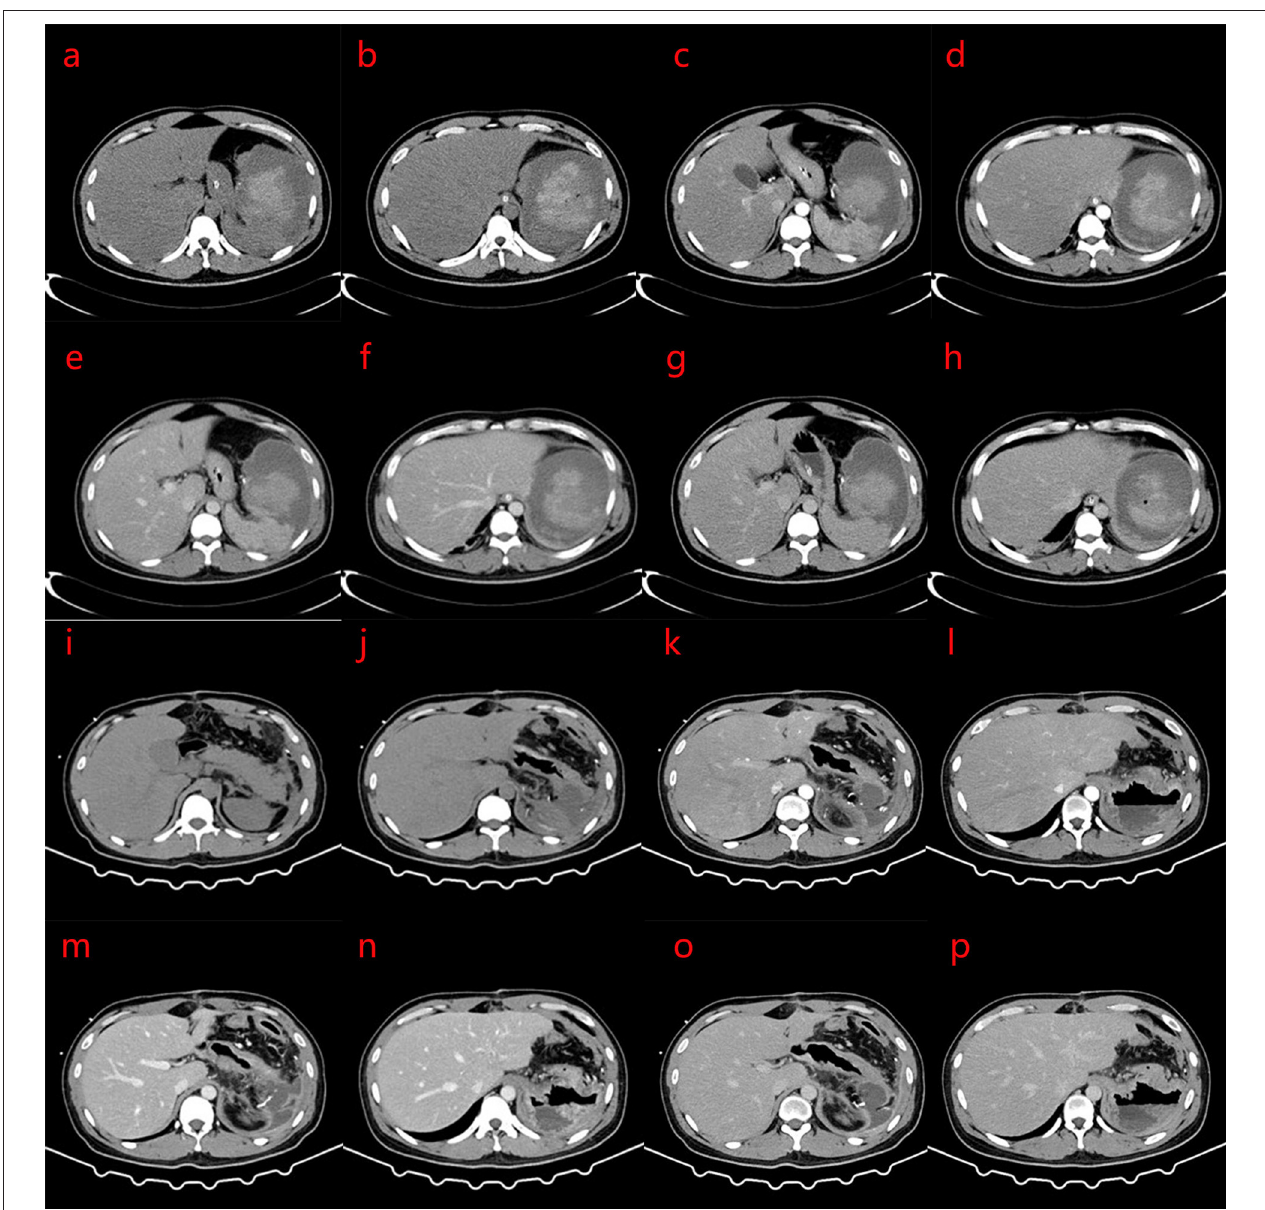
FIGURE 2 | (a–p) Computed tomography (CT) scan 9 days after splenic artery embolization: the spleen is enlarged, with strip-like and spot-like dense shadows and gas accumulation in the operation area; a mass mixed density shadow is seen, and the internal high density mass was about 8.0 × 7.3 × 7.8cm. The CT value of the plain scan is about 11–67 HU. The enhanced scan part shows progressive enhancement. The edge is surrounded by low-density shadows, the wall is slightly enhanced, the boundary with the adjacent spleen is unclear, and this extends to the paracolic space. The rest of the spleen parenchymal part of the enhancement is reduced, showing irregular flakes or wedges. Patchy and cord-like high-density shadows are seen in the remaining adjacent abdominal fat spaces, with poorly defined boundaries, and the left renal anterior fascia is thickened. No obvious space-occupying lesions are found in the pancreas. The density of liver parenchyma is significantly reduced. The clinical impression is a change after splenic artery embolization, which is better than before, and severe fatty liver. (i–p) Changes after splenectomy, patchy and cord-like dense shadows are seen in the operation area, and the adjacent abdominal fat space, with poorly defined borders, and scattered patchy low-density shadow. The larger size mass was approximately 5.3 × 5.6cm, with part of it encapsulated. Part of the edge of the enhanced scan shows mild enhancement, and the anterior fascia of the left kidney is thickened. (a,b,i,j) CT plain scans; (c,d,k,l) Arterial phase of CT; (e,f,m,n) Portal vein phase of CT; (g,h,o,p) Delay phase of